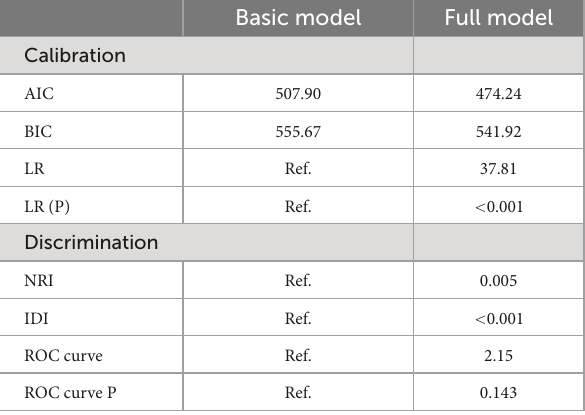
TABLE 3 Prediction accuracy gained by adding risk factors to basic model for the risk of non-suicidal self-injury